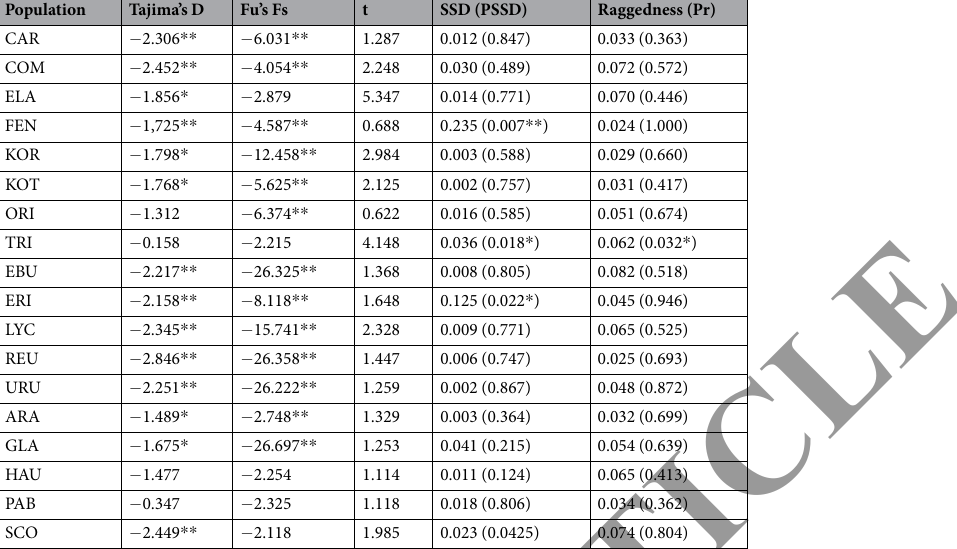
Table 4. Tajima’s D, Fu’s Fs and parameters of the mismatch distribution for almond populations based on all markers. Time since the population expansion (t), Sum of square deviations (SSD) and its p-value (PSSD) for test of the validity of the sudden expansion model, Harpending’s Raggedness index (Raggedness) and its p-value (Pr) for the test of goodness-of-fit. For details on population see Table 1. * Significant at P < 0.05; ** Significant at P <